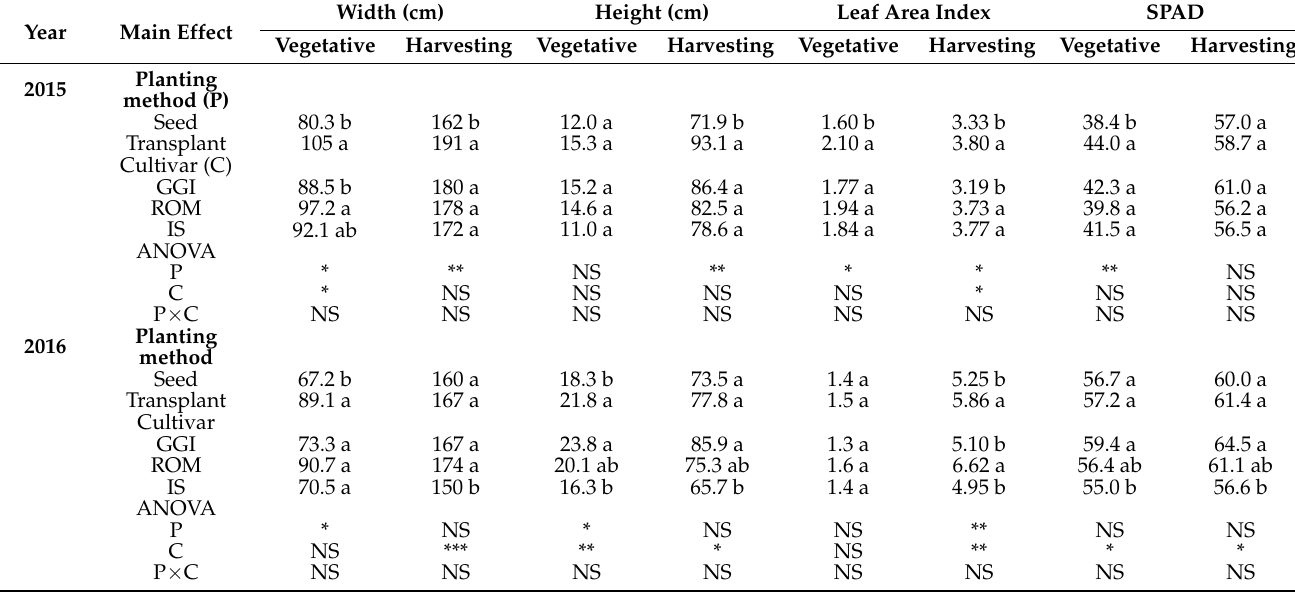
Parameters used as a measure of plant morphology (width and height) and their main physiological processes (leaf area index (LAI), chlorophyll content index (SPAD), photosynthesis ( Pn ), stomatal conductance ( g s), and transpiration ( E )) were determined at the vegetative and harvesting stages in both growing seasons. In 2015, plant width, height, and LAI at the harvesting stage as well as SPAD at the vegetative stage were higher in transplanted vs. directly seeded artichokes (Table 3). In 2016, plant size at the vegetation stage was larger for transplanting than the direct seeding method. However, cultivar responses were not significant or inconsistent across the study period. In addition, Pn , g s, and E for direct seeding and transplanting were statistically similar in both years (2015, 2016) and across cultivars (data not presented). Photosynthesis values ranged from 2016); g s was about 0.4 mol m − 2 s − 1 in 2015 and 0.5 mol m − 2 s − 1 in 2016; E was about and E ) values for 2015 were about 50% lower than 2016 across cultivars and over planting methods (direct seeding and transplanting) though the differences between years (2015 vs. 2016) were not statistically analyzed. Table 3. Plant width and height, leaf area index (LAI), and chlorophyll content index (SPAD) of artichoke cultivars (Green Globe Improved (GGI), Romolo (ROM), and Imperial Star (IS)) as influenced by planting method (direct seeding—Seed, and transplanting—Transplant) during 2015 and 2016 seasons. Harvesting Vegetative